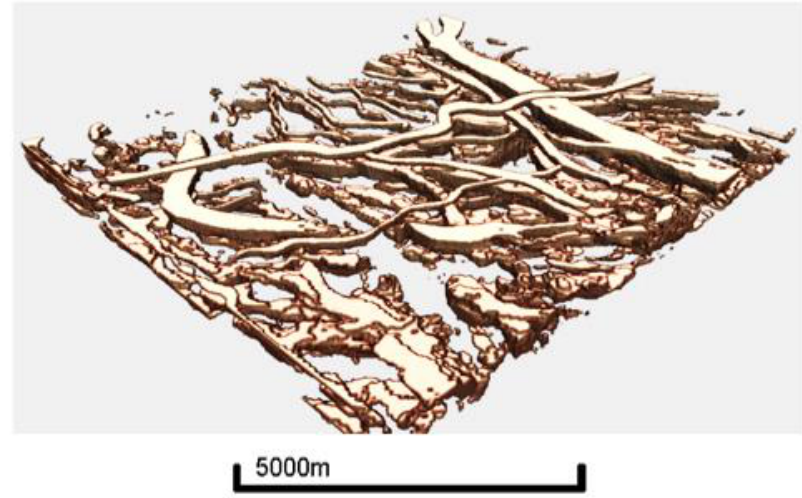
Figure 27. Examples of geobodies obtained from U-Net predictions.